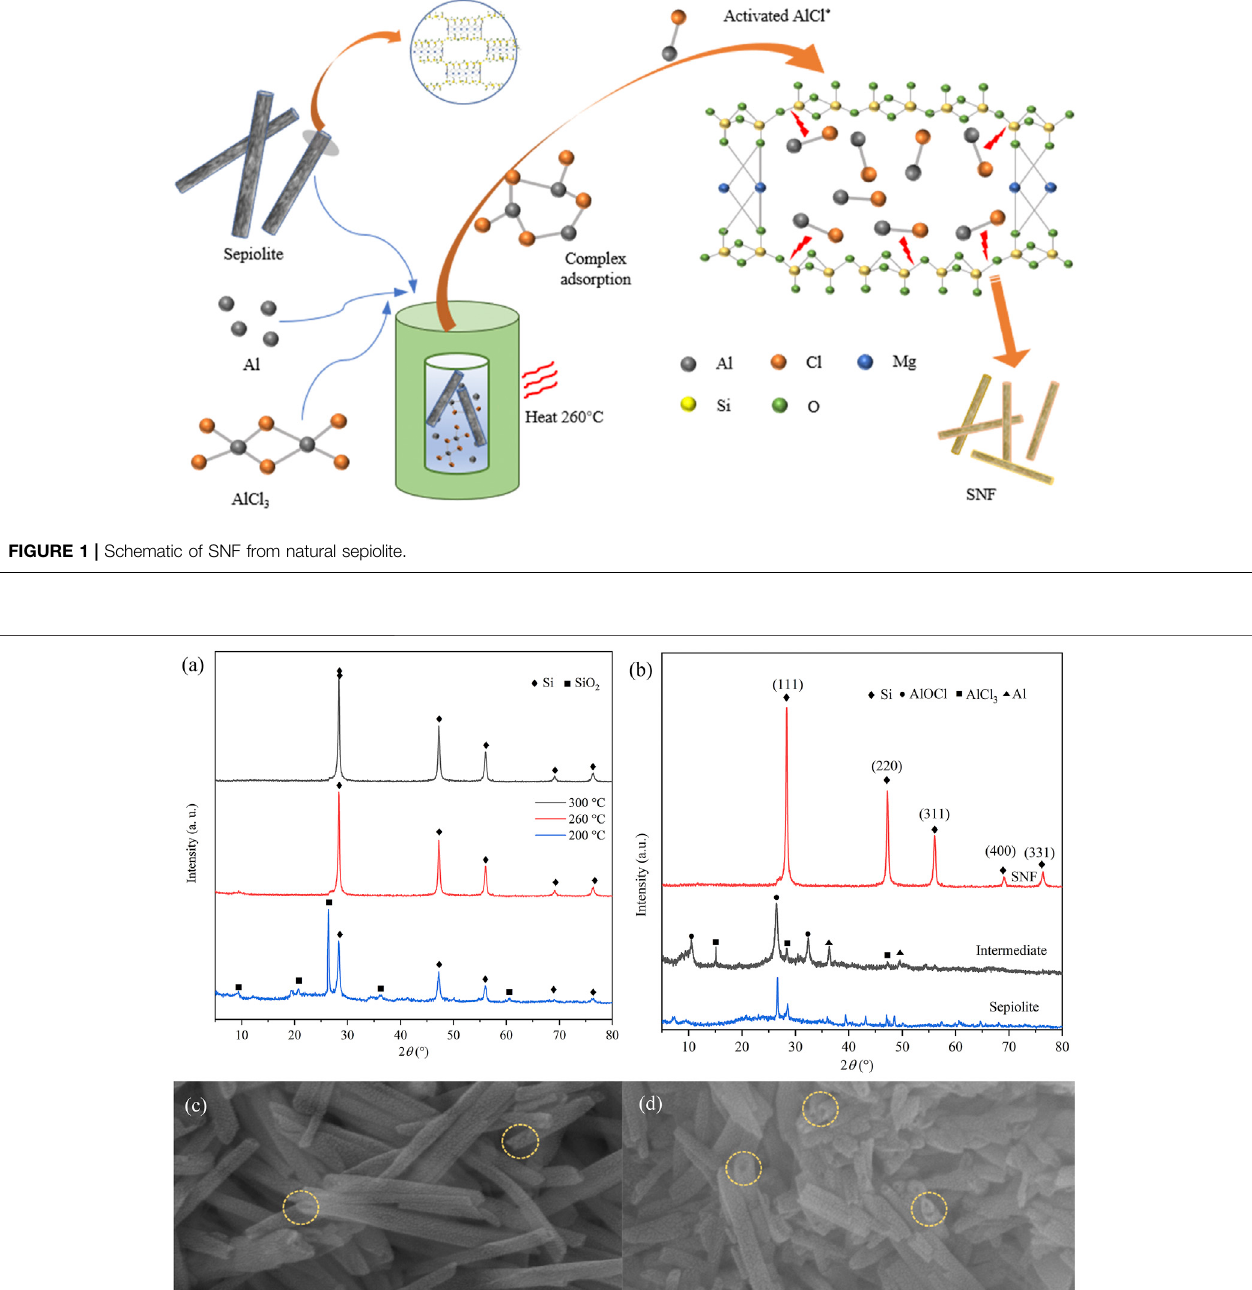
Frontiers in Chemistry |